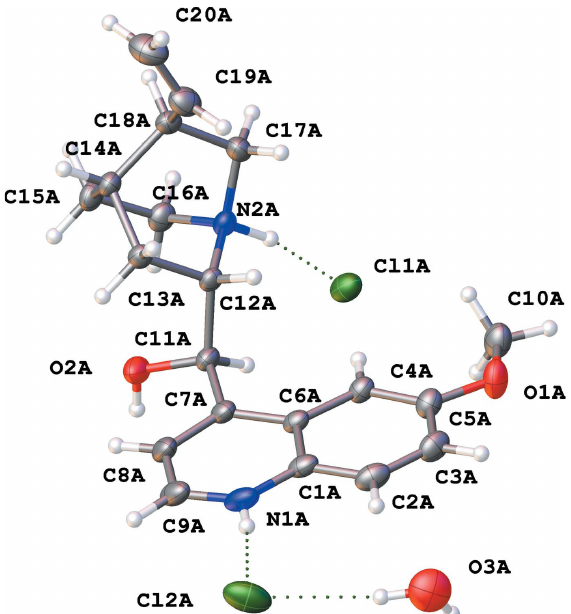
Figure 1 Labeling scheme for the cationic portion of the structure. Four distinct dicationic moieties are in the asymmetric unit, labeled using suffixes A , B , C and D .